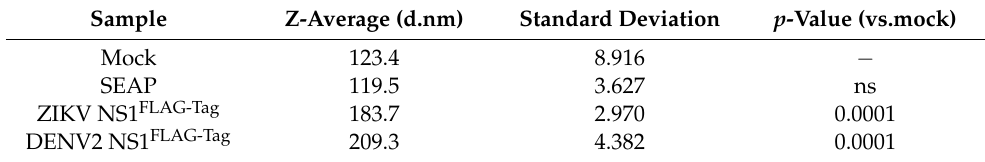
Table 2. Overexpression of ZIKV and DENV2 NS1 lead to an increase in exosomes